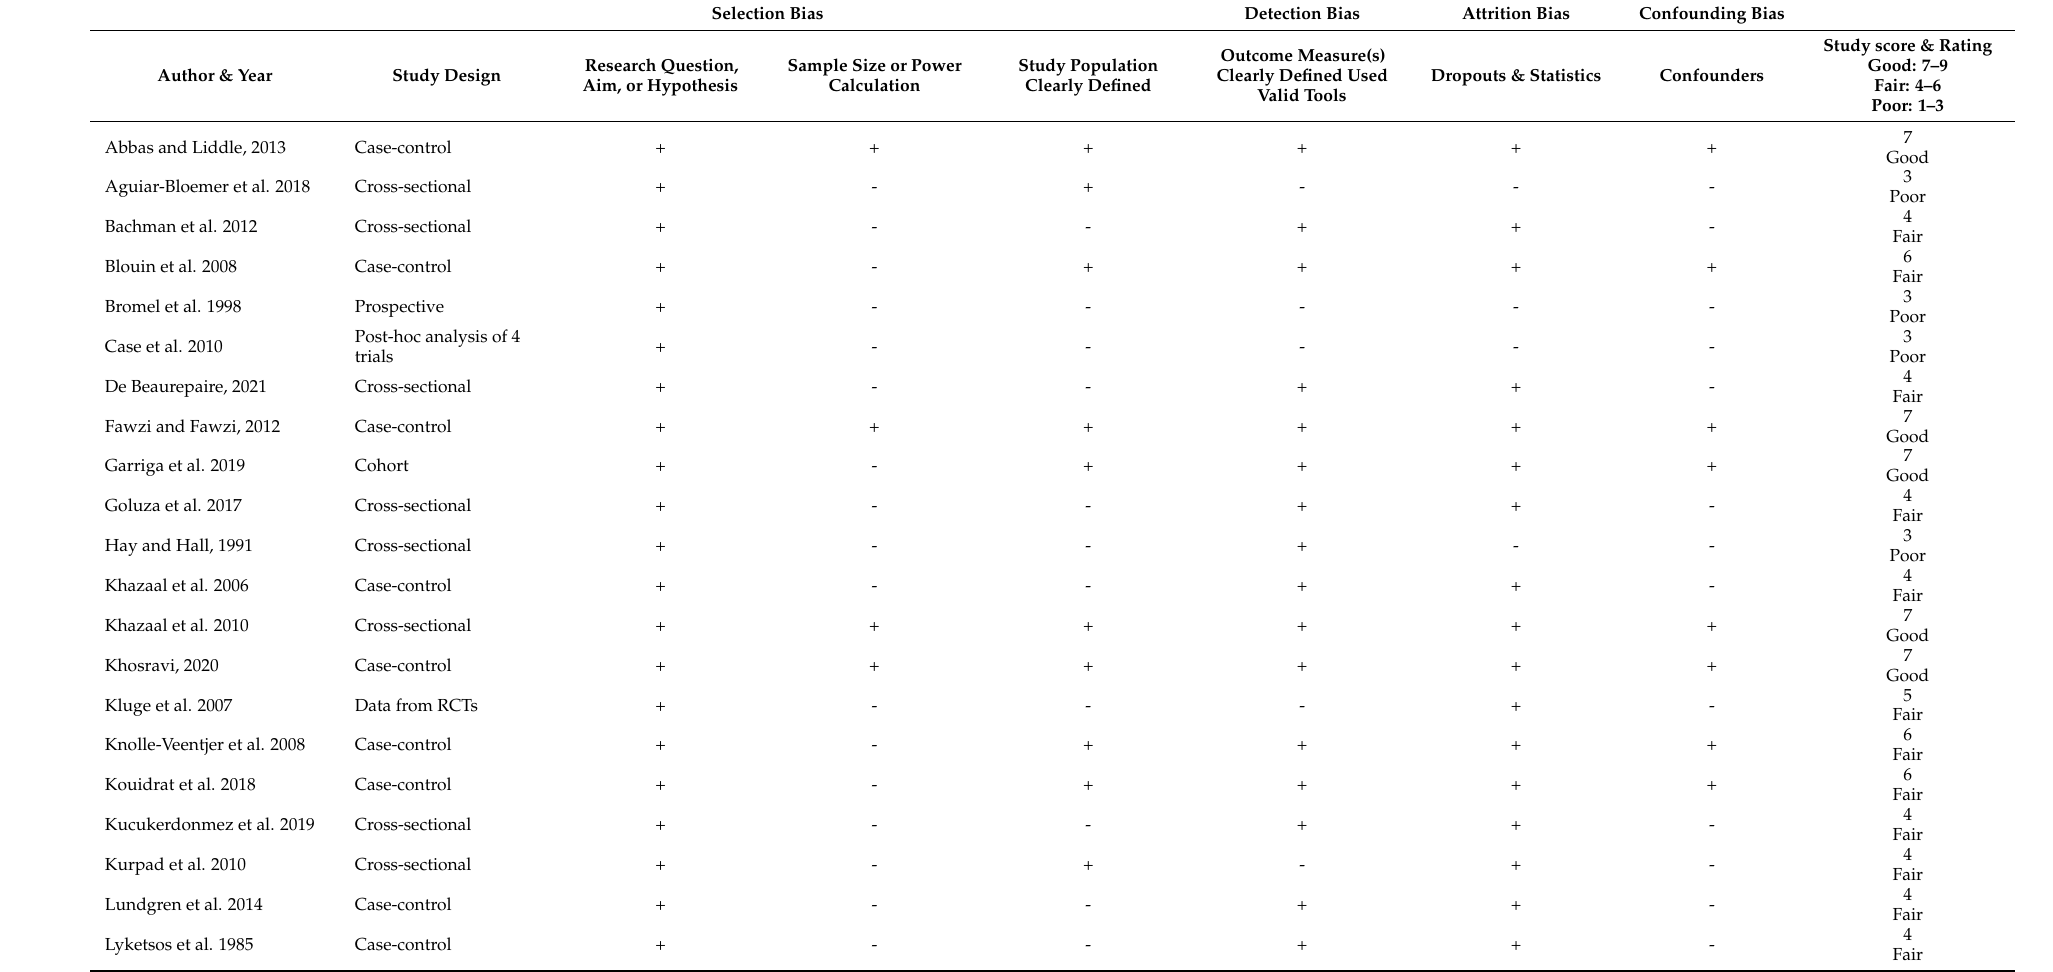
Table 4. Summary of Quality